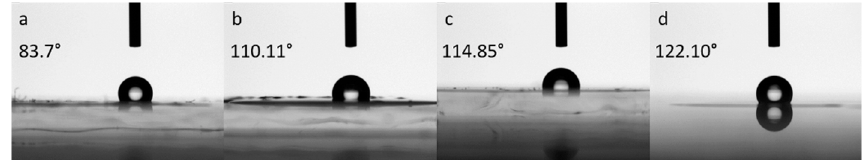
Figure 5. Water contact angles (WCA) measured for: PMS from run 14 of Table 2 ( a ); PMSI from run 19 of Table 2 ( b ); PI from run 7 of Table 1 ( c ) PMI from run 17 of Table 2 (d).